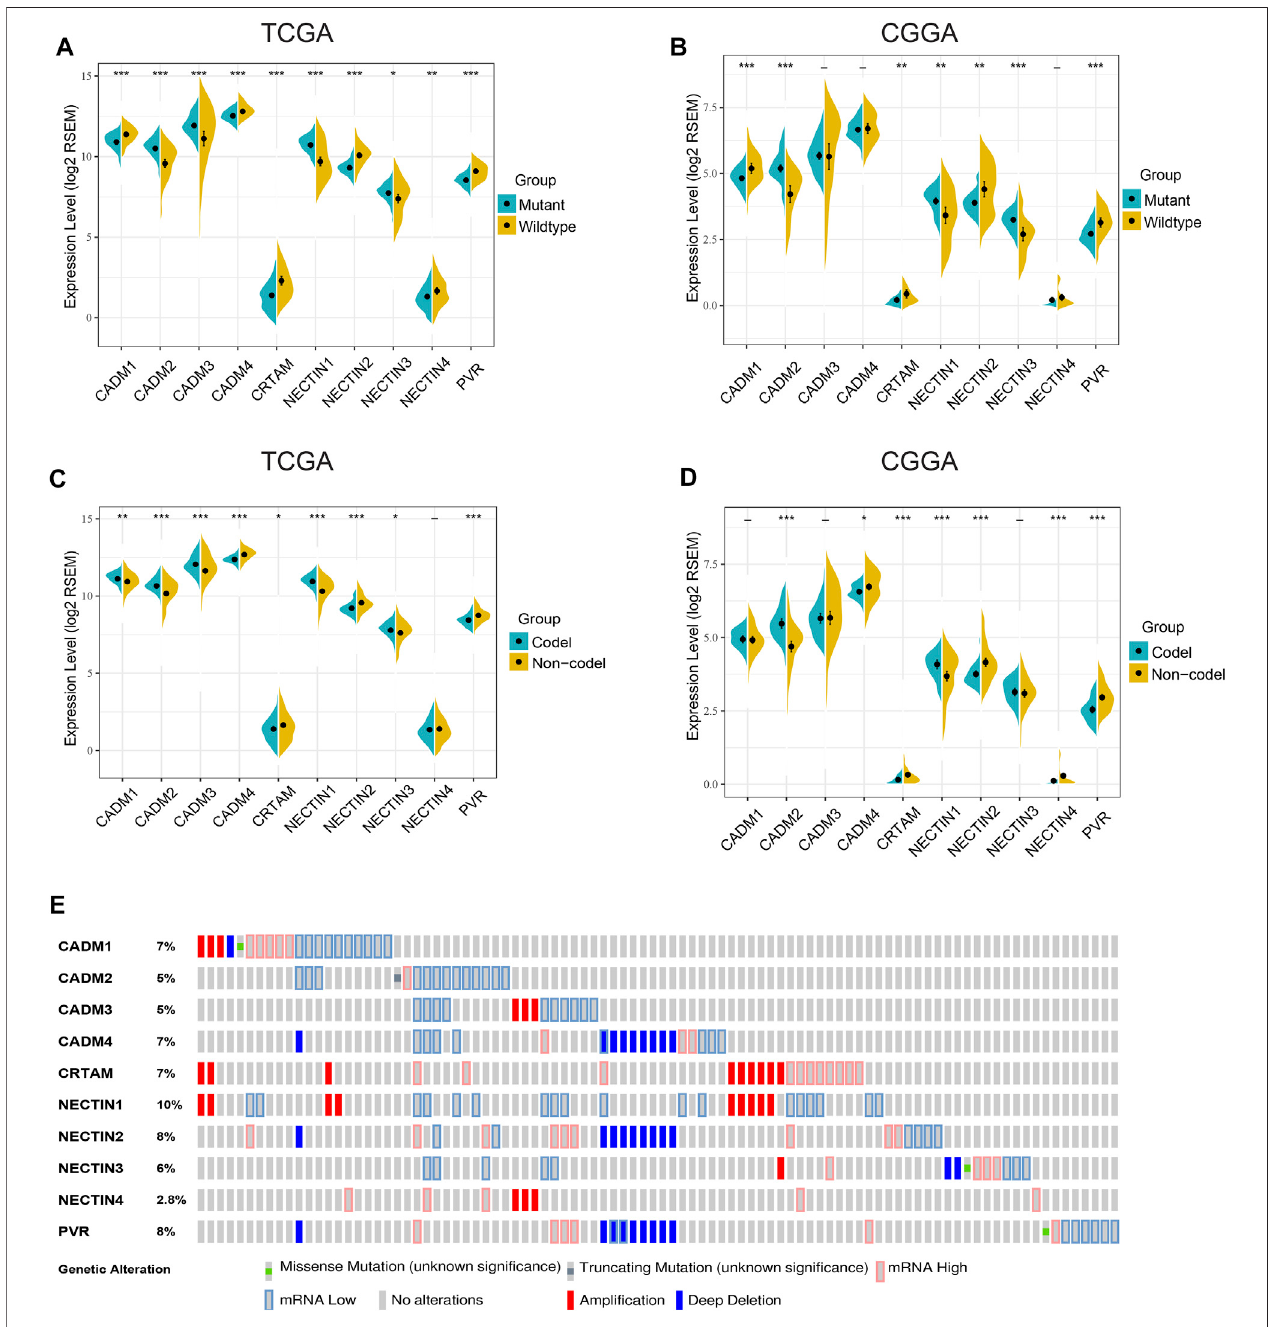
FIGURE 2 | Gene alteration and associations between NECTIN family and necls and LGG molecular subtype. (A,B) The expression level of nectin family members and necls were differentially in IDH wildtype and mutant samples in TCGA (A) and CGGA (B) . (C,D) The expression level of nectin family members and necls were differentially in 1p19q codeletion and non-codeletion samples in TCGA (C) and CGGA (D) . E OncoPrint visual summary of Genomic alterations on query of nectin family members and necls in LGG (cBioportal).